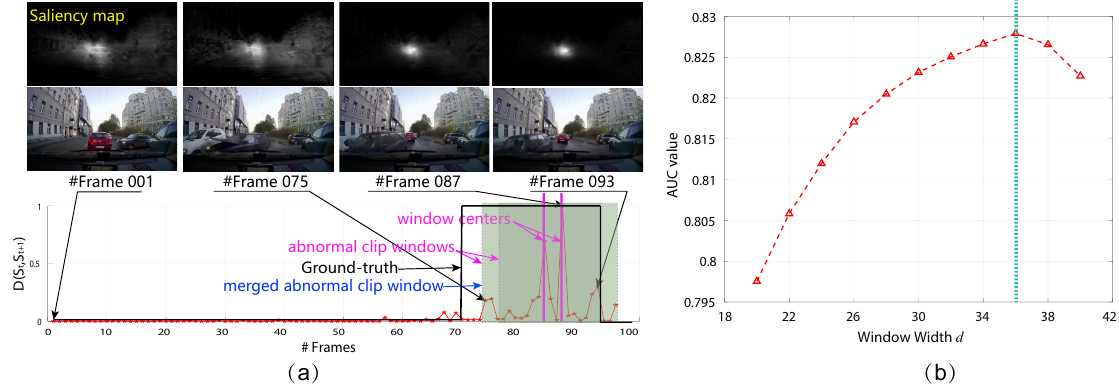
Figure 3. Illustration of temporally abnormal sub-clip detection. ( a ) a typical example; ( b ) the AUC value w.r.t. d when K is set as 4. We find that d = 36 generates the best AUC value for